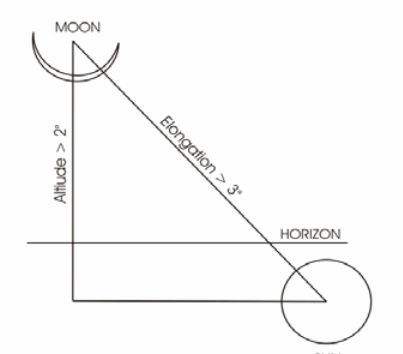
Figure 1. Geometrical parameters of Imkanur rukyah criteria used in Malaysia